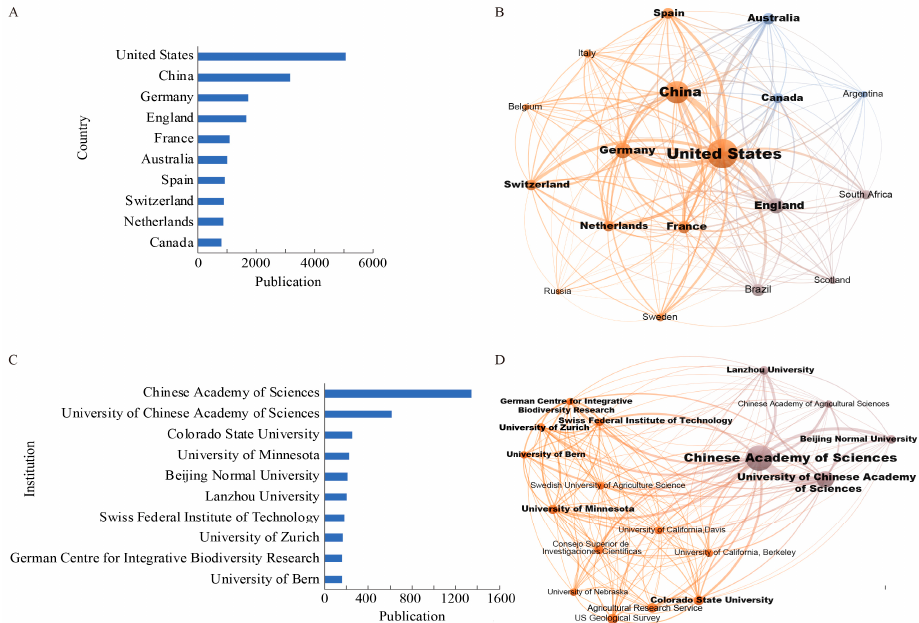
Figure 4. Ranking of countries and institutions by publishing articles. Subfigure ( A , B ) demonstrated the ranking of countries by the number of publications; Subfigure ( C , D ) demonstrated the ranking of institutions by the number of publications.